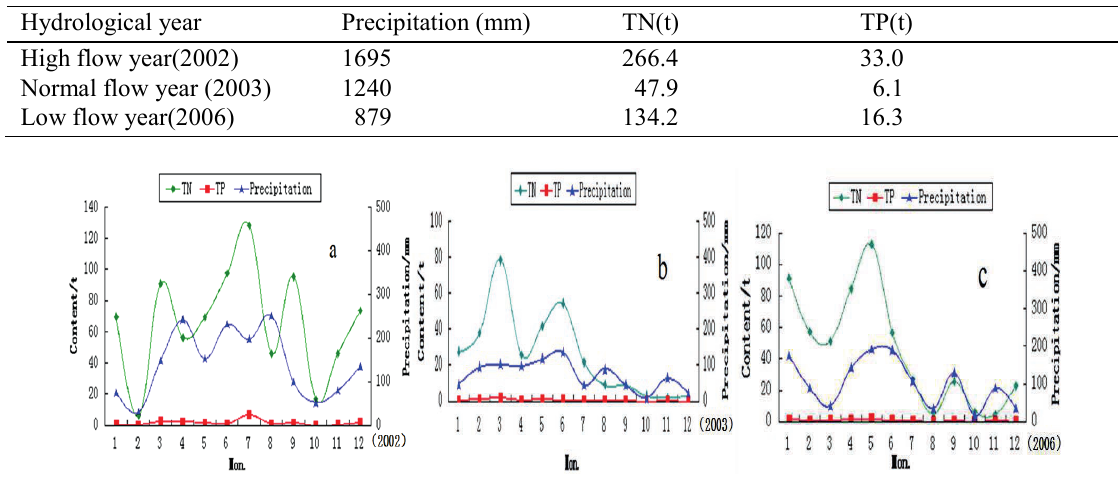
Table 4 The simulation result of non-point source pollution in different typical hydrologic years.